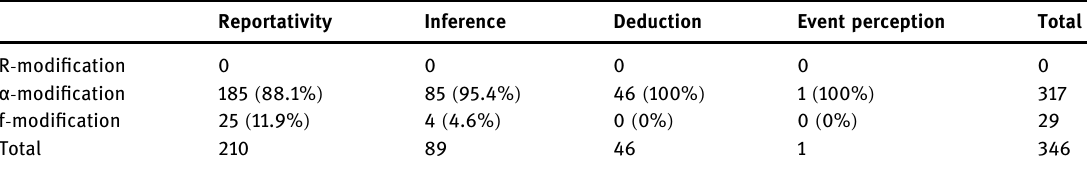
Table 4: Types of modi fi cation in the sample